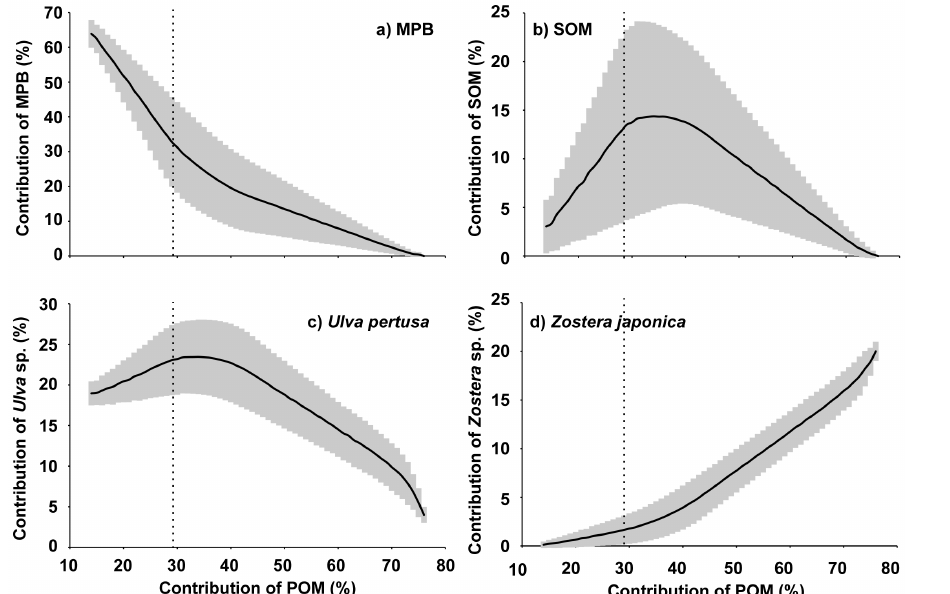
Figure 8. Scatter plot illustrating the relationship between the contributions of phytoplankton and other food sources. (a) MPB, (b) SOM, (c) U. pertusa , and (d) Z. japonica . Solid lines and grey region indicate mean and standard deviations for every 1% increase of POM contribution, respectively. Vertical dotted line indicates the upper limit to the phytoplankton contribution based on their abundance and the food demand of the clam.